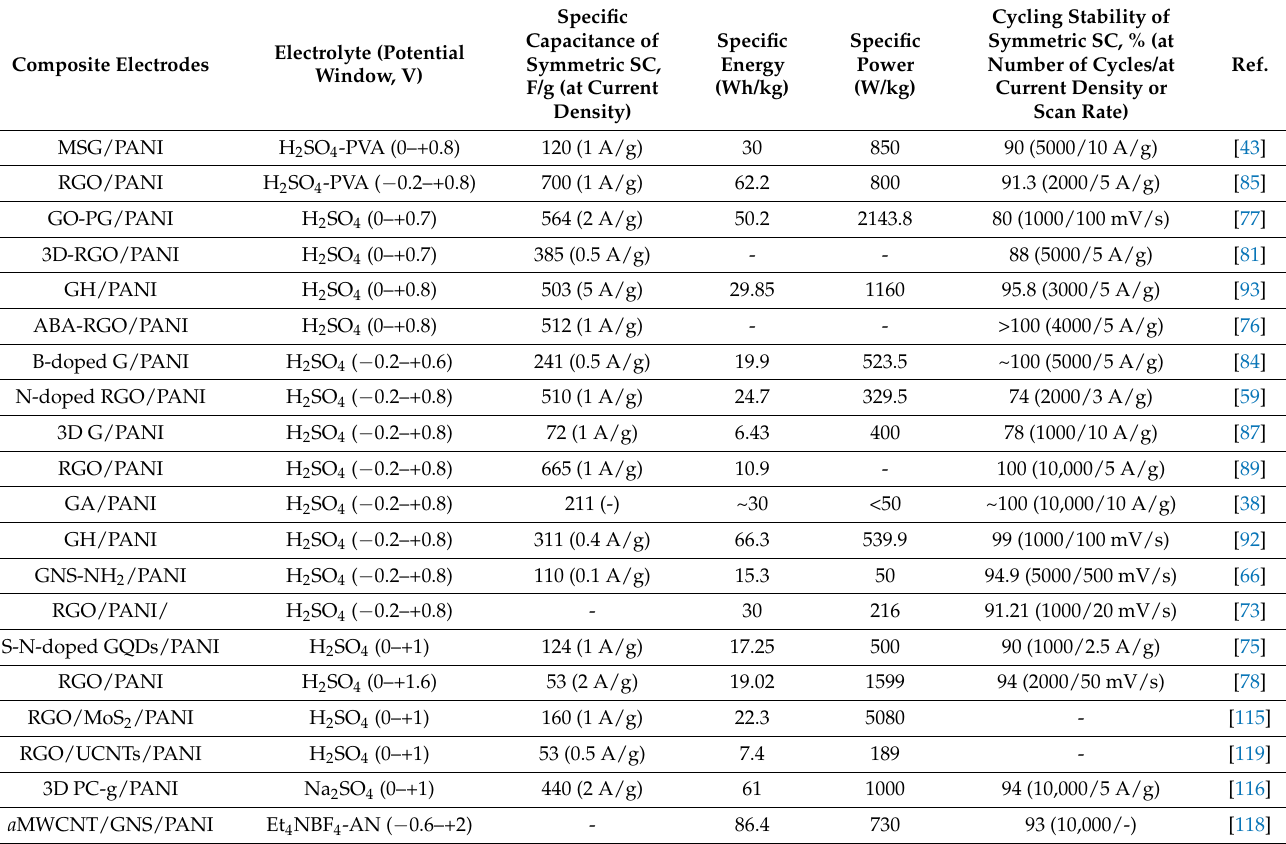
Table 3. Literature data of the symmetric supercapacitors made of PANI and graphene-related components (ordered by the electrolyte